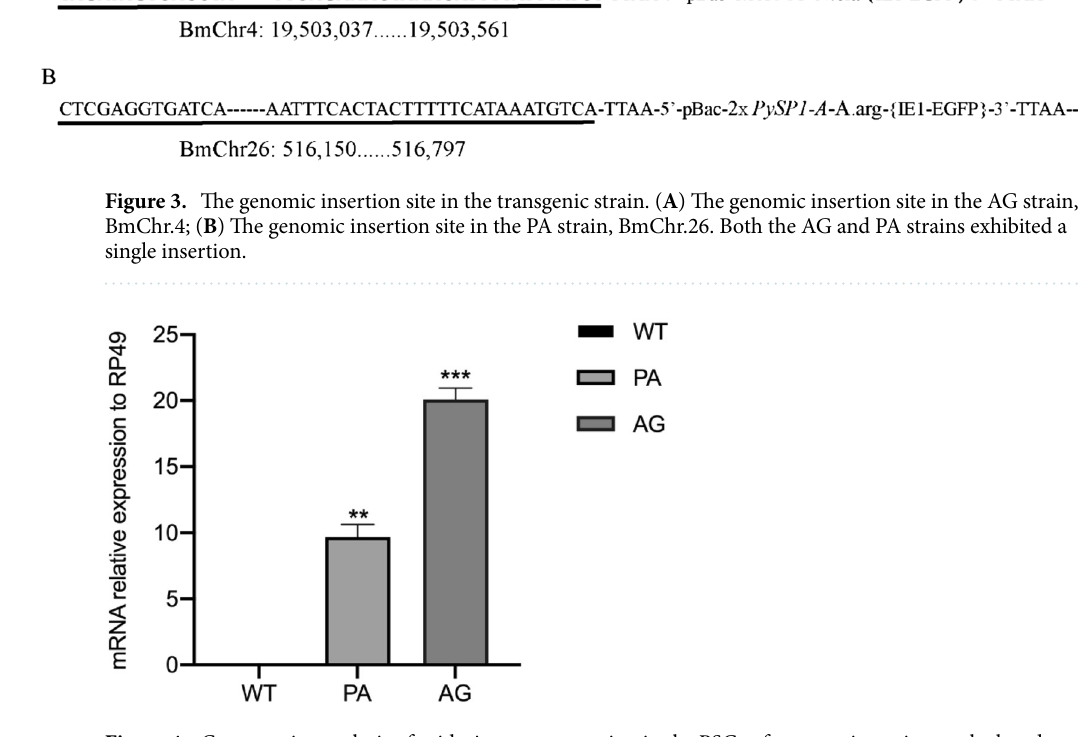
Figure 4. Comparative analysis of spidroin gene expression in the PSGs of transgenic strains on the last day of the fifth instar. The mean ± SD values were derived from three biological replicate experiments. The significance of the difference between transgenic strains (PA; AG) and WT was calculated using two-tailed Student’s t-tests. *P < 0.05; **P < 0.01; ***P <